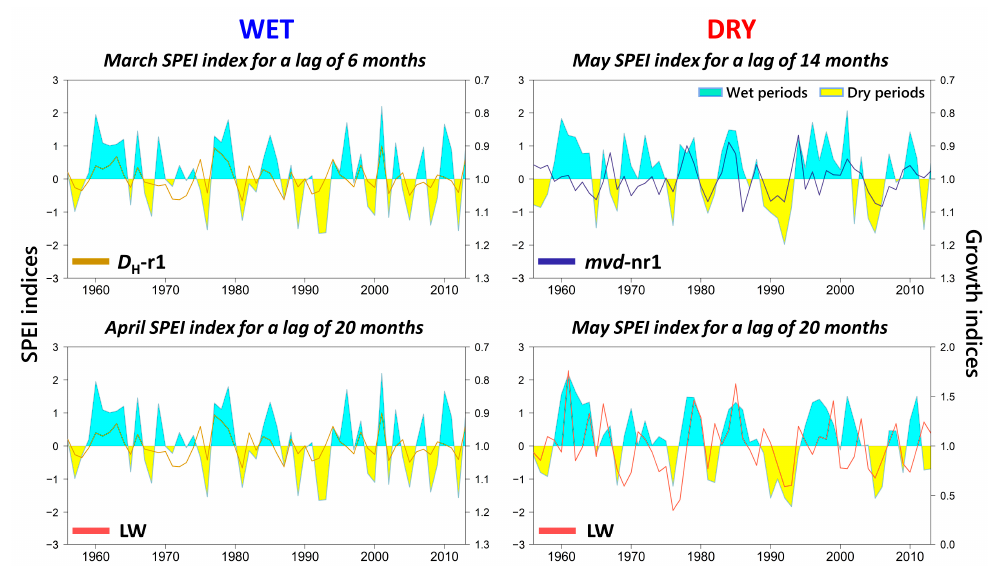
Figure 5. Adjustment between growth variables and SPEI values for the months and time scales maximizing correlation at both stands for the period 1956–2013 (58 years). D H -r1: hydraulically weighted diameter of the first row; mvd- nr1: mean vessel diameter of vessels not belonging to the first row; LW: latewood width.